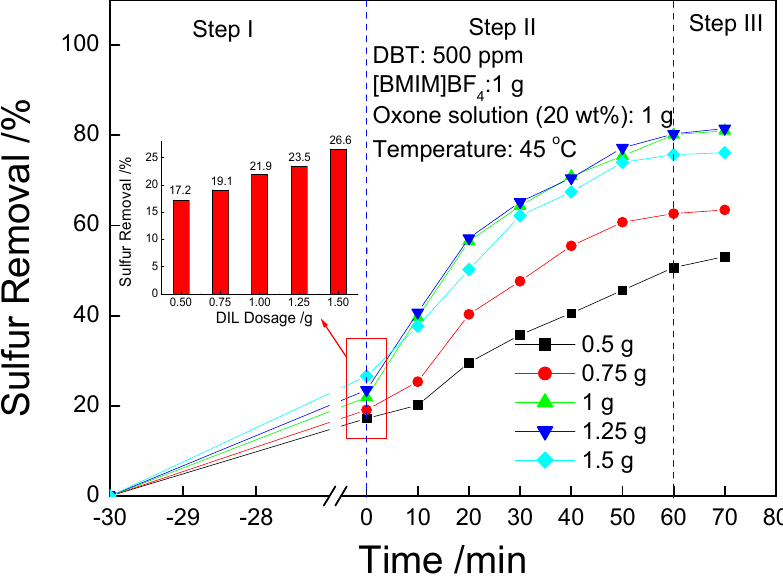
Figure 5. Effect of di-[EMIM]CoCl 3 dosage.